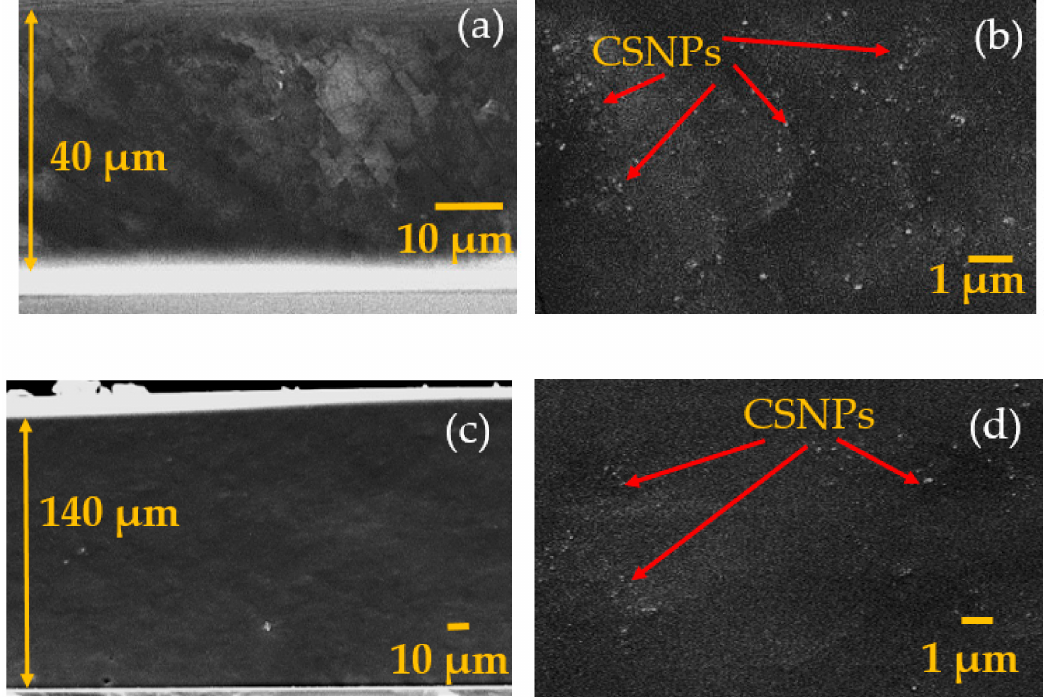
Figure 2. Scanning electron microscopy (SEM) photographs of the CSNPs–PDMS composite films (p10 and p40). Cross-sectional views for entire film thickness are shown in ( a , c ) for p10 and p40, respectively. Enlarged views for p10 and p40 are also shown in ( b , d